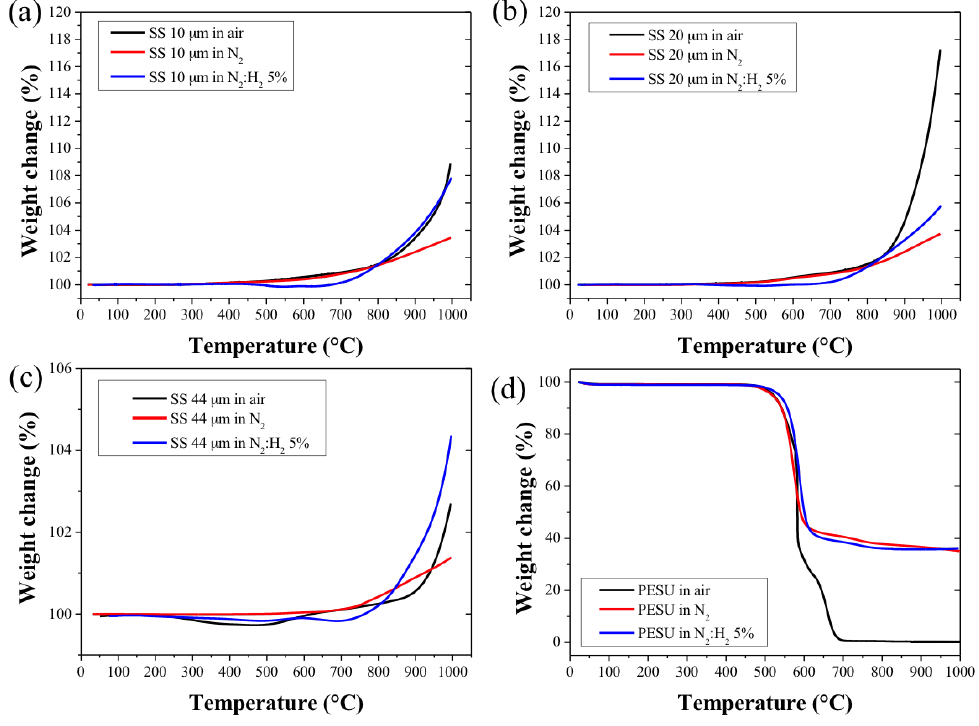
Figure 3. Thermogravimetry (TGA) thermal profiles measured in air, inert, and reducing atmosphere of ( a ): 10 μm SS powder, ( b ): 20 μm SS powder, ( c ): 44 μm SS powder and ( d ): PESU polymer